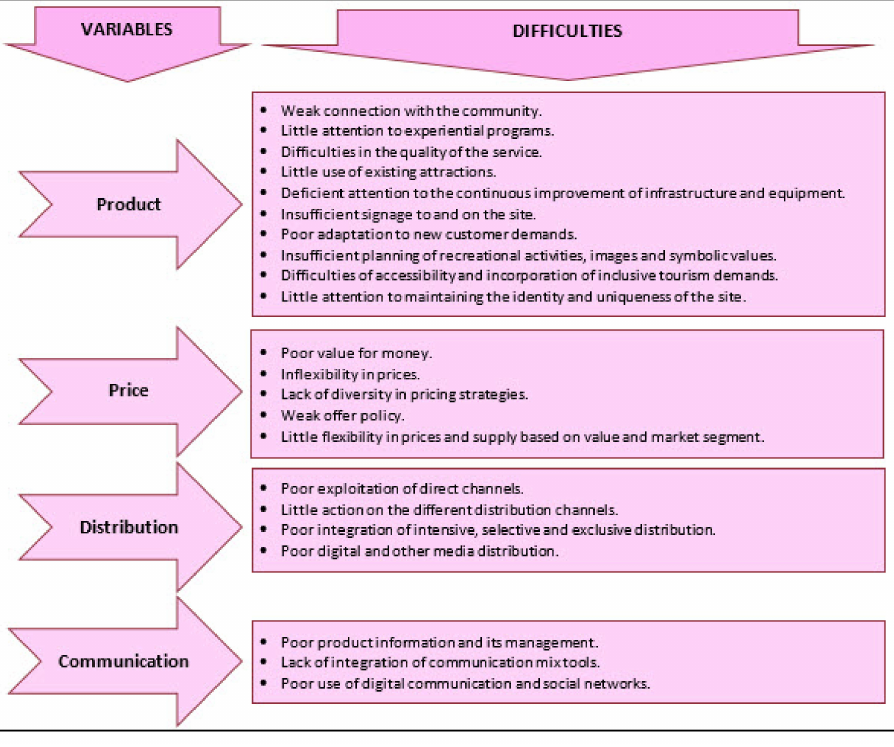
Figure 7. Results of the marketing study at Hacienda Guachinango Source: own elaboration based on the results of the marketing study at Hacienda